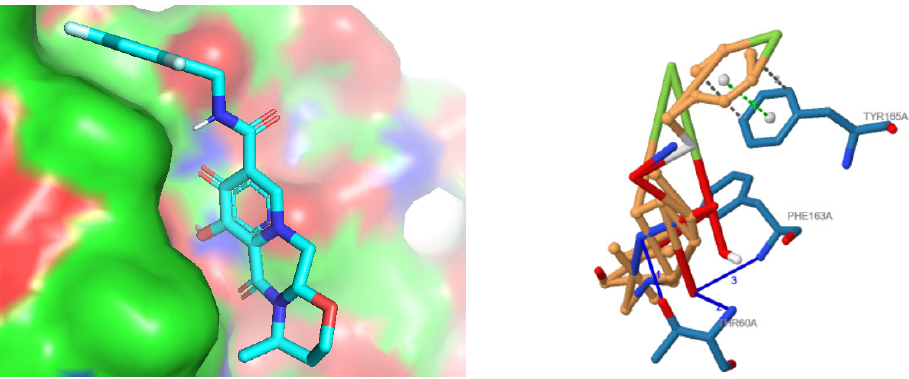
Figure 4. Chain engineered structure of dolutegravir; red points are representing the sites of addi ‐ tion of chains or atoms; brown color shows the added atom of fluorine and chlorine is presented by green color.